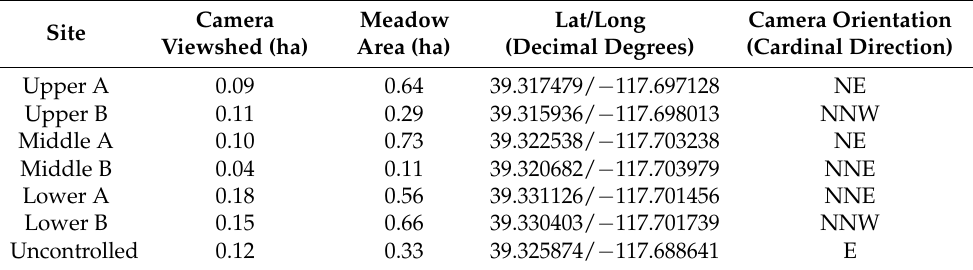
Table 1. Meadow and phenocam information, including the area of the phenocam field of view (i.e., camera viewshed), the areal extent of the meadows, latitude and longitude of the meadows, and the orientation of each phenocam. Camera Meadow Lat/Long Camera Orientation Site Viewshed (ha) Area (ha) (Decimal Degrees) (Cardinal Direction) Upper A 0.09 0.64 39.317479/ − 117.697128 NE 0.11 0.29 39.315936/ − 117.698013 39.322538/ − 117.703238 0.56 39.331126/ − 117.701456 NNE Lower B 0.15 0.66 39.330403/ − 117.701739 NNW Uncontrolled 0.12 0.33 39.325874/ − 117.688641